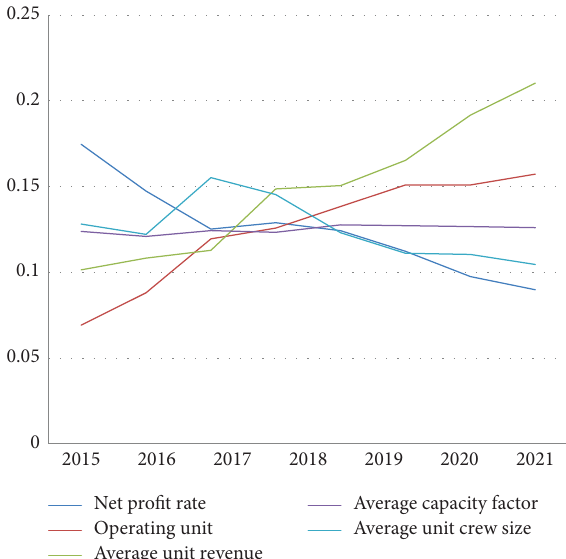
Figure 4: Normalized CGN nuclear power operation normalized data